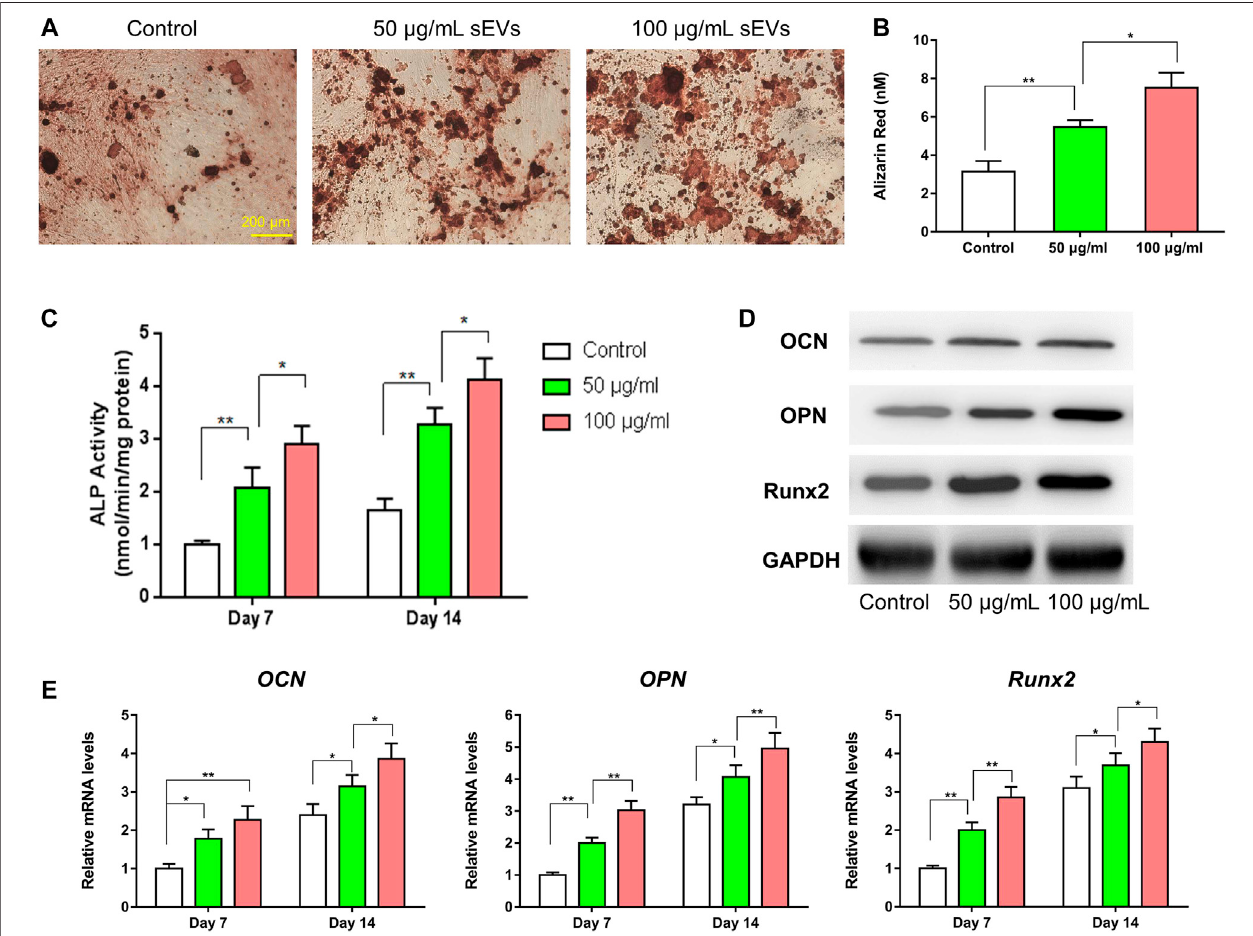
FIGURE 2| Enhanced osteogenic effect of sEVs in vitro (*) p < 0.05 (**) p < 0.01 (A) ARS results from stimulation of sEVs on BMSCs after 14 days ofculture. Scale bar (cid:1) 200 μ m (B) QuantitativeanalysisofARS (C) QuantifcationofALPstainingafterincubationofBMSCswithsEVsfor7and14 days (D) Westernblottingassayforthe protein expression of OCN, OPN, and Runx2 (E) mRNA level of pro-osteogenic-related genes ( OCN , OPN , and Runx2 ) in BMSCs exposed to different treatments.